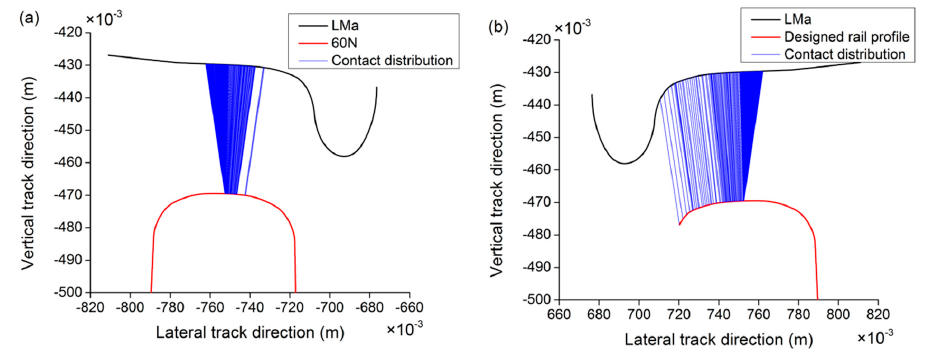
Figure 14. Wheel-rail contact distribution at both sides. ( a ) Left LMa profile and CHN60; ( b ) Right LMa profile and reverse designed rail profile.